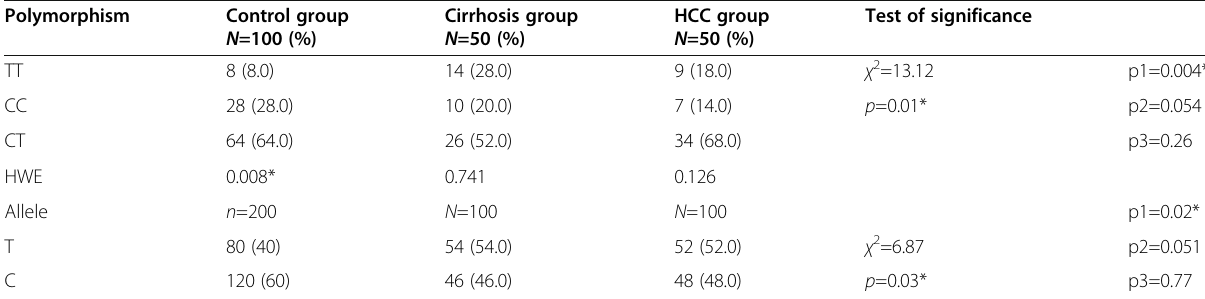
Table 6 Genotypes and alleles distribution among studied groups Polymorphism